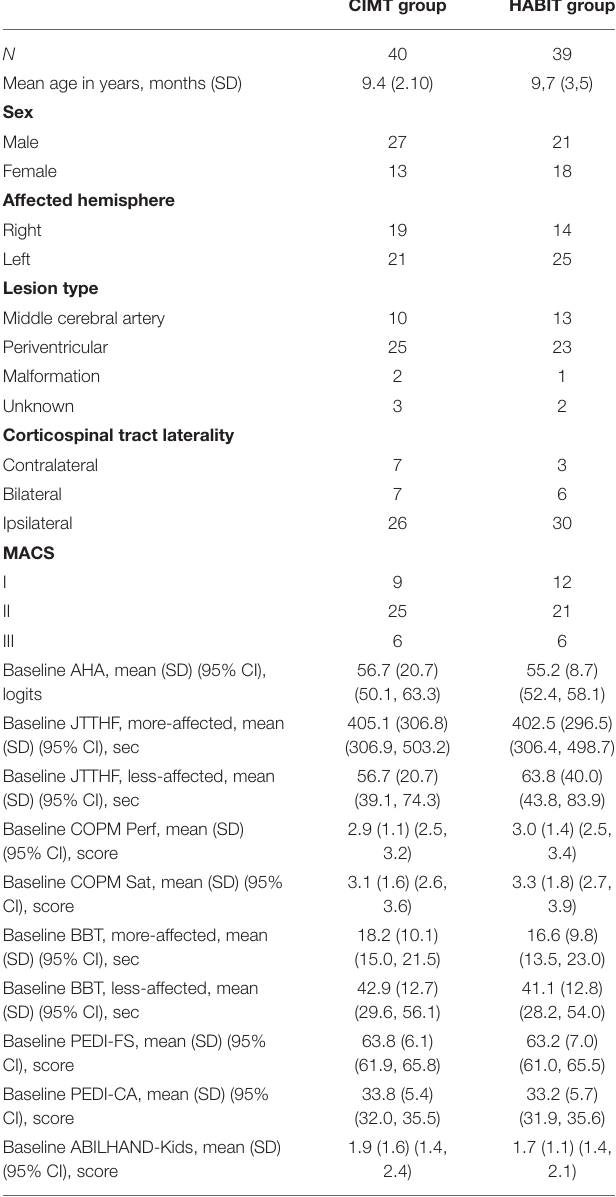
TABLE 1 | Included participant